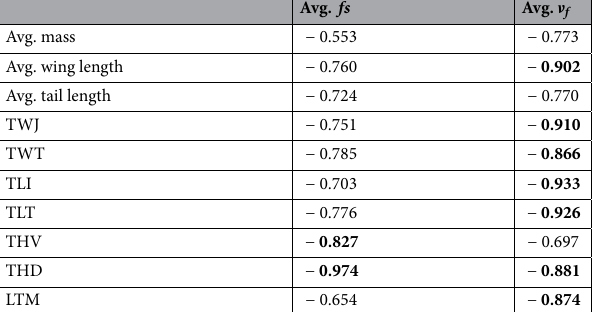
Table 6. Pearson’s product-moment correlation coefficient ( r ) between the physical measurements and the frequency parameters (average frequency slope per harmonic number fs , and frequency maximum per harmonic number ν f ). Instances for which r > 0.800 are highlighted in bold. For the syringeal measurements: TWJ = posterior tympanum width, TLJ = posterior tympanum depth; TWT = anterior tympanum width, TLT = anterior tympanum depth; THD and THV = medial height of the tympanum dorsally and ventrally; LTM = width of lateral tympaniform